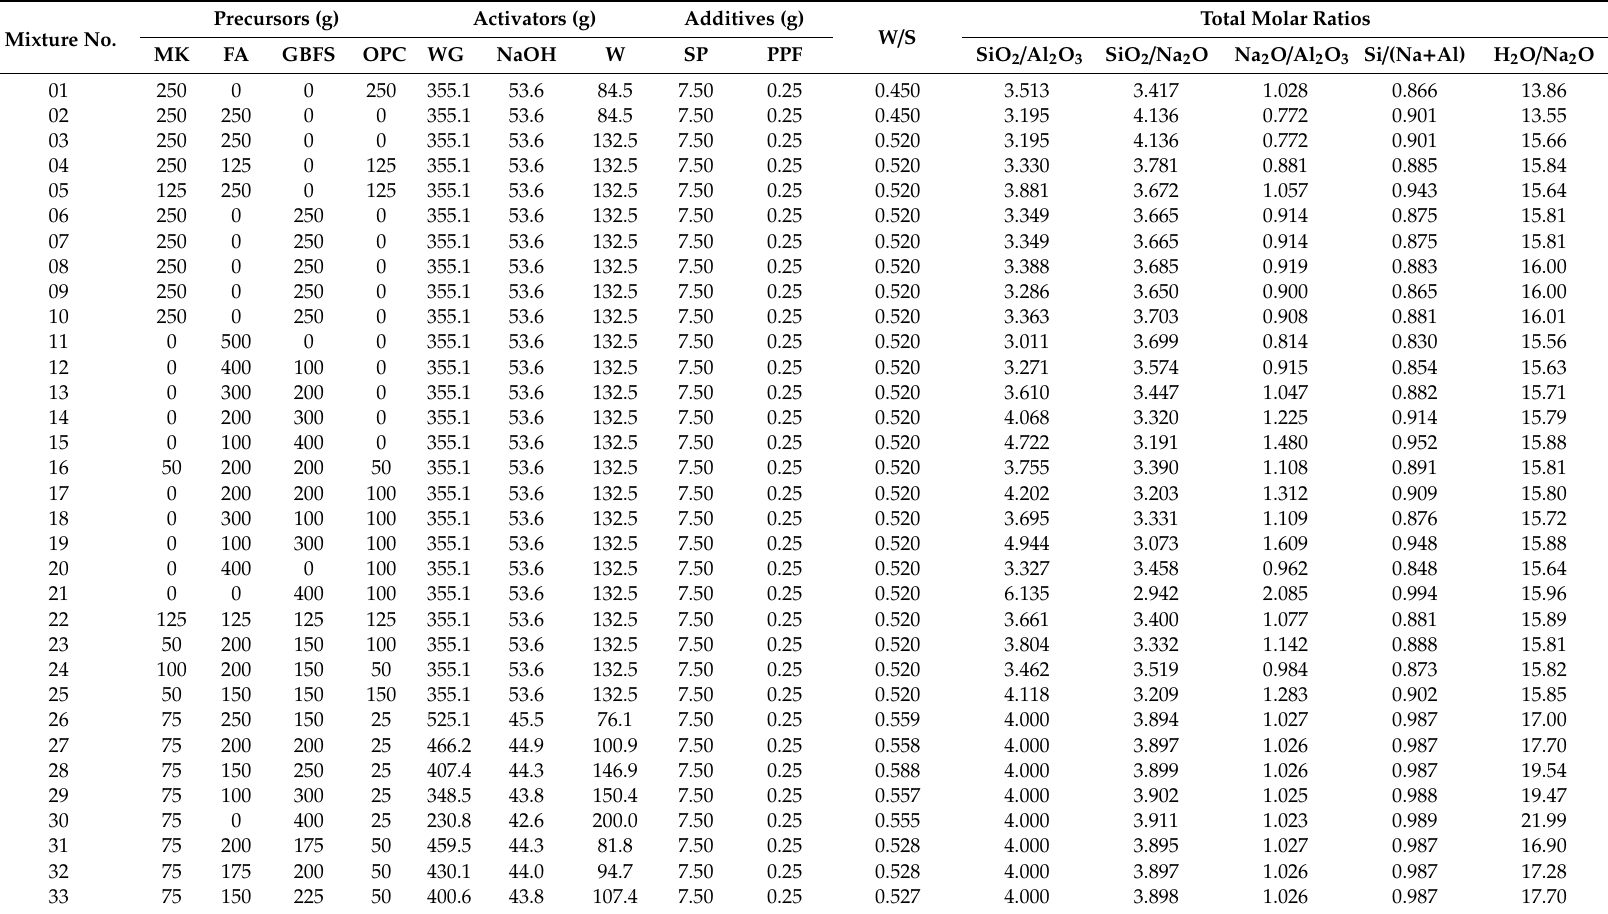
Table 2. Mixture proportions of geopolymer